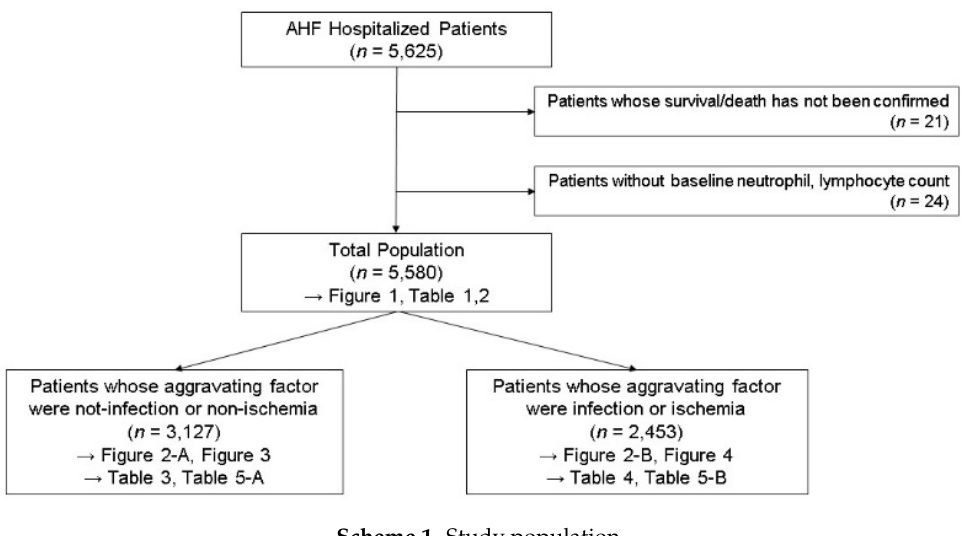
Table 1. Baseline clinical characteristics of heart failure (HF) patients stratified by quartiles of neutrophil to lymphocyte ratio at admission.